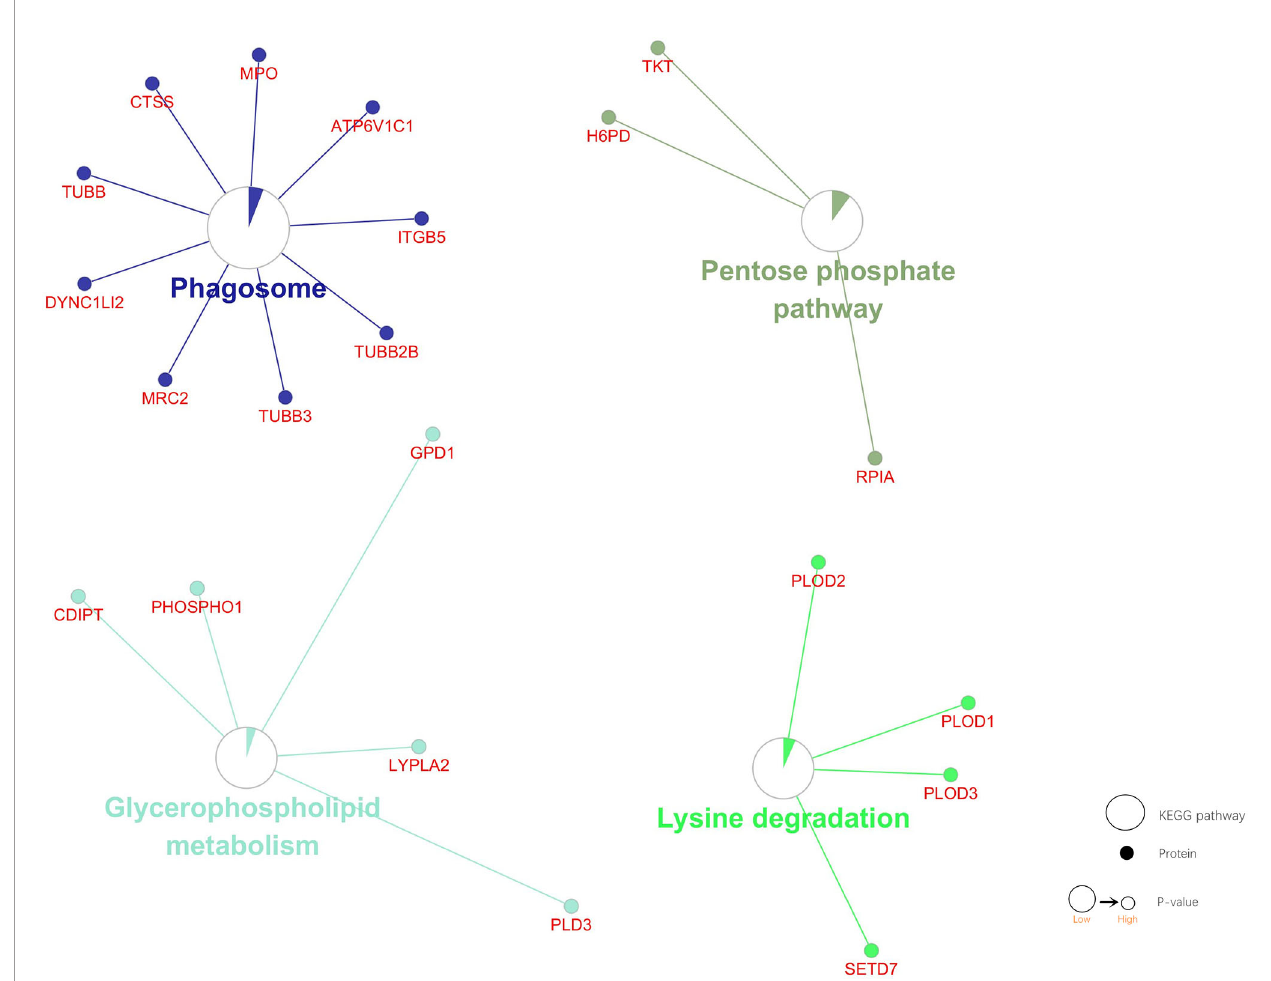
FIGURE 5 | KEGG pathway enrichment analysis of DEPs. Four pathways and associated DEPs are shown. Dot: protein. Circulation: KEGG pathway. Circle size: the smaller the P value, the bigger the circle. Area of the color in circle represents the percentage of associated DEPs in the Circle